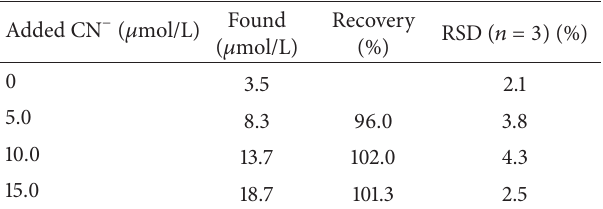
Table 1: Analytical results of CN − in a cyanide-containing gold leach waste